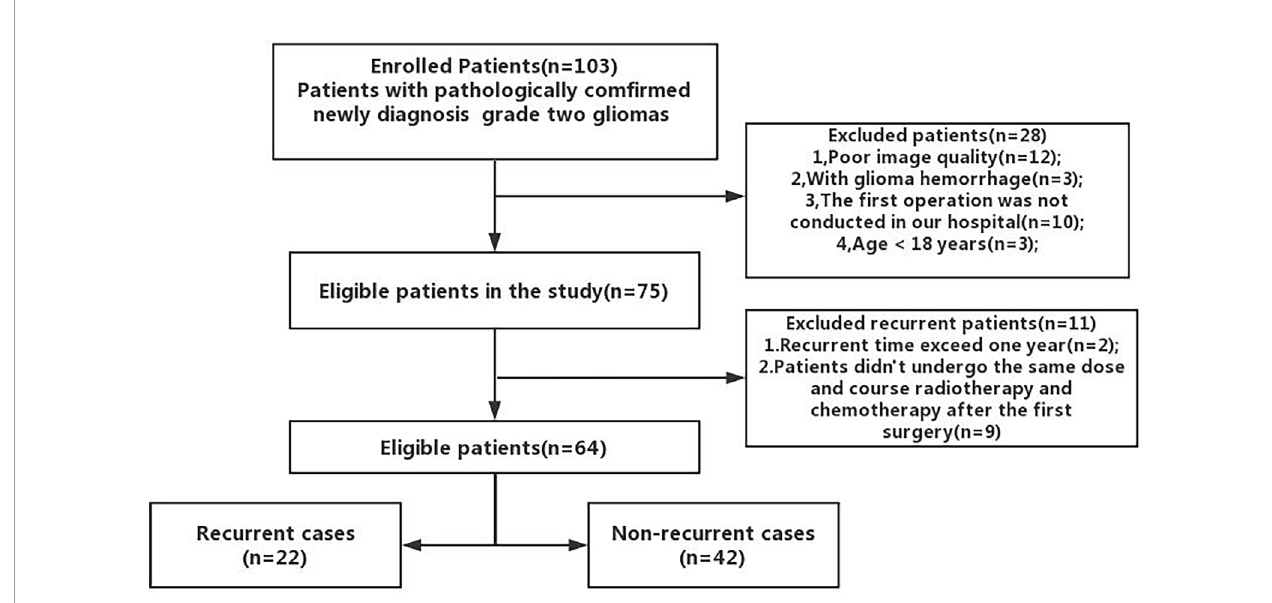
FIGURE 1 | Flow diagram illustrating the patient selection process.